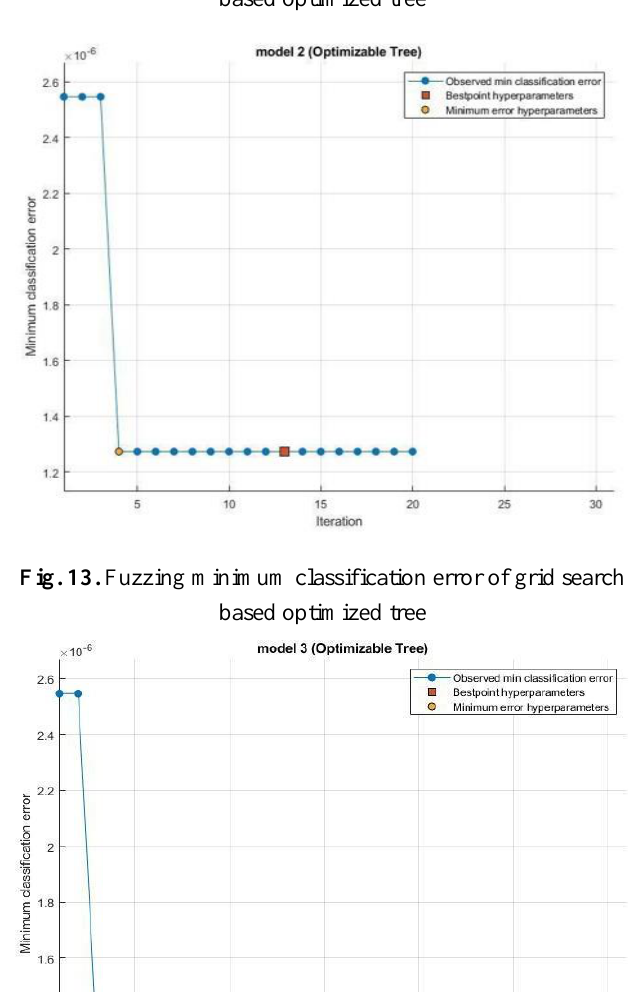
Fig. 12. Fuzzing minimum classification error of bayesian based optimized tree